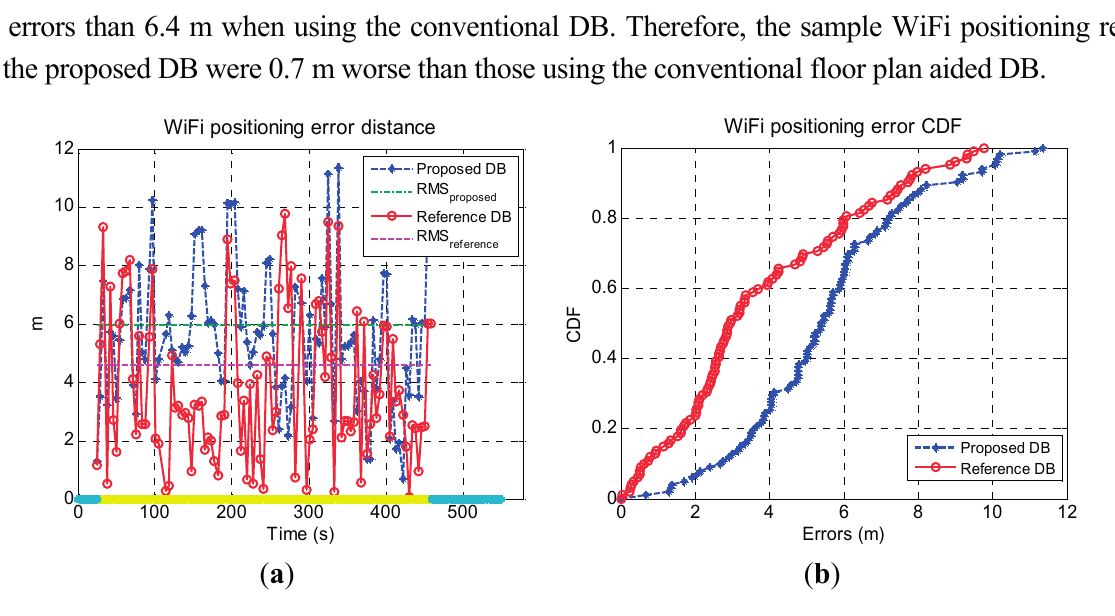
Figure 20. Time series of WiFi fingerprinting errors ( a ) and corresponding CDF ( b